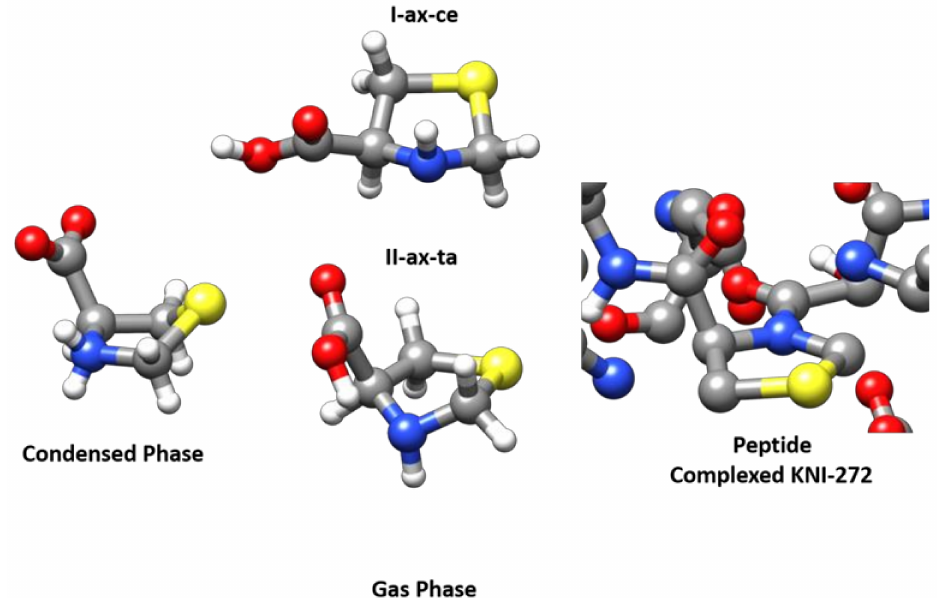
Figure 5. The MP2/6-311++G(2d,p) structures of the two observed forms I-ax-ce and II-ax-ta of SPro are compared to that of the single conformer observed from X-ray diffraction for the zwitterionic form [30,54] (Condensed Phase) in the solid state and with the structure of the SPro fragment observed for KNI complexed to the HIV protease (Peptide complexed KNI-272)